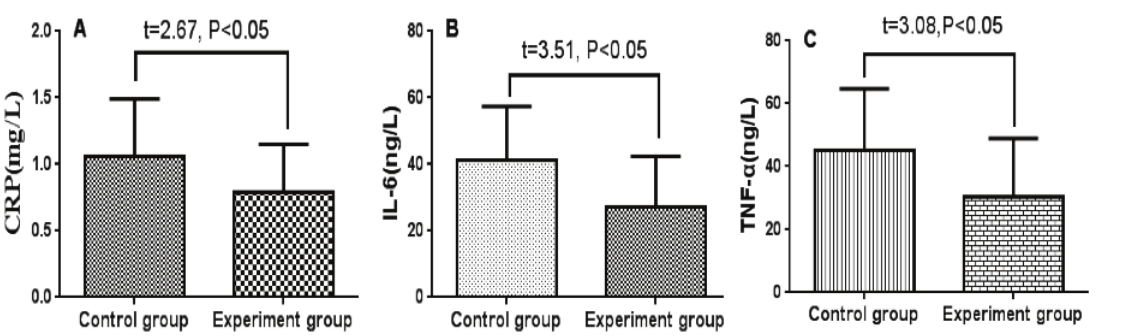
Figure 1: Bar plot for serum level of CRP, IL-6 and TNF-α in experiment and control group(A: serum CRP; B: serum IL-6; C: serum